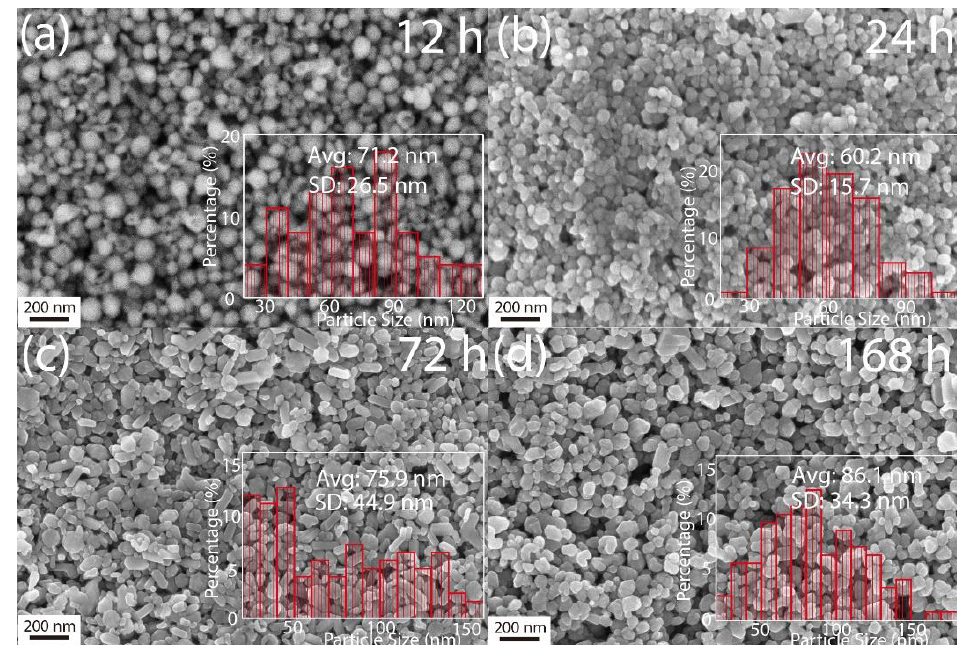
Figure 4. ( a – d ) SEM images of hydrothermal samples with different duration at 260 °C with 60 μL N 2 H 4 ·H 2 O, inset with the size distribution analysis.